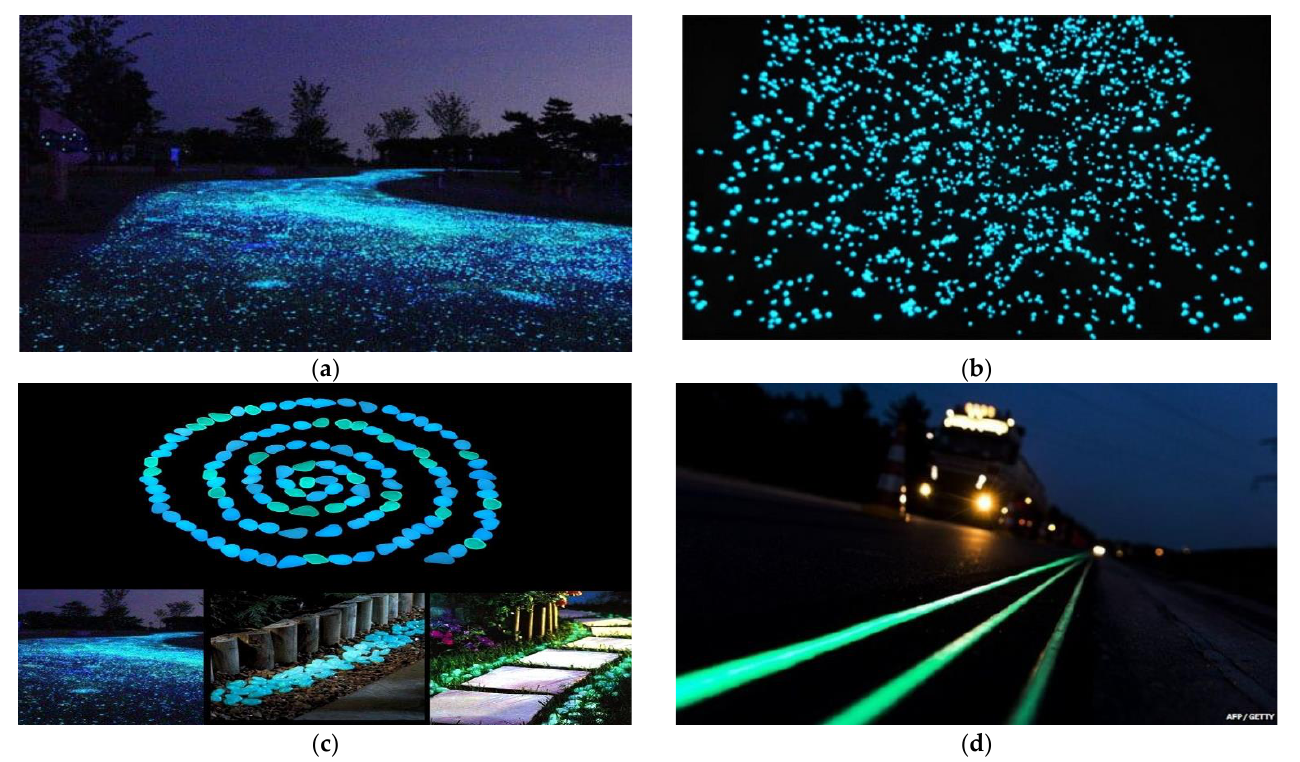
Figure 2. Different products used to illuminate the roadway at night [18]: ( a ) Luminescent product; ( b ) Core Glow products; ( c ) Unime pebbles; ( d ) photo-luminescent paint.